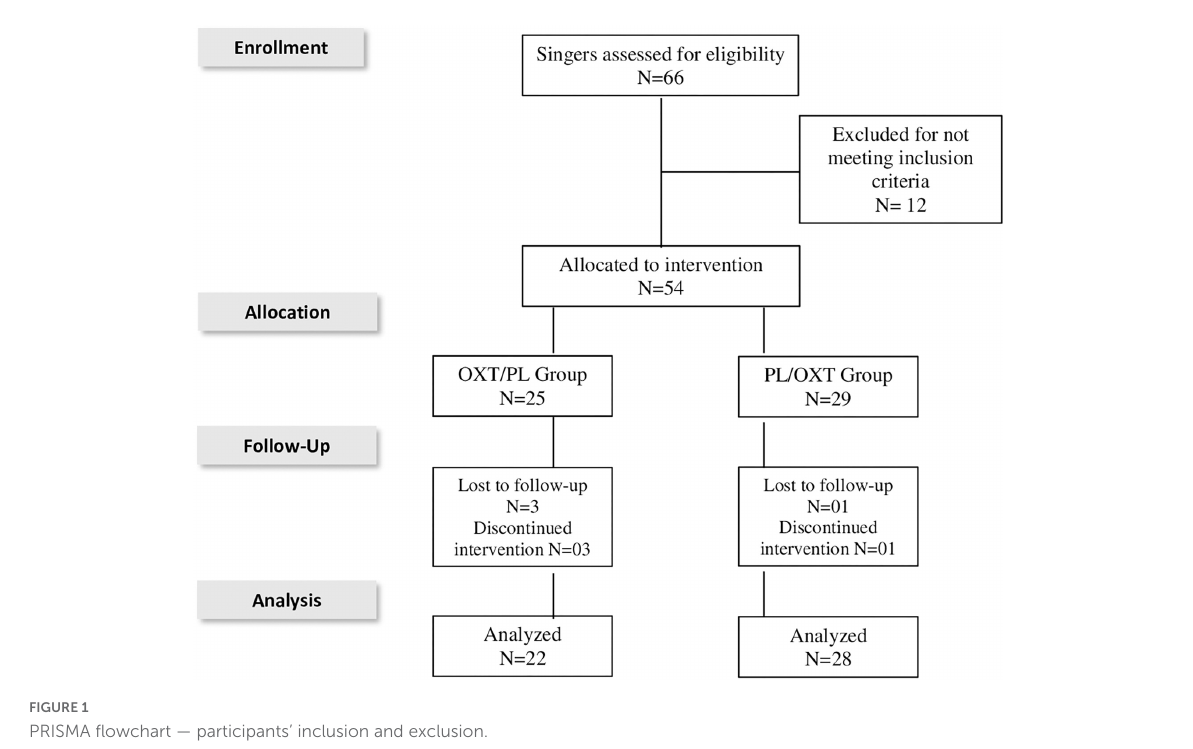
FIGURE1 PRISMA flowchart — participants’ inclusion and exclusion.